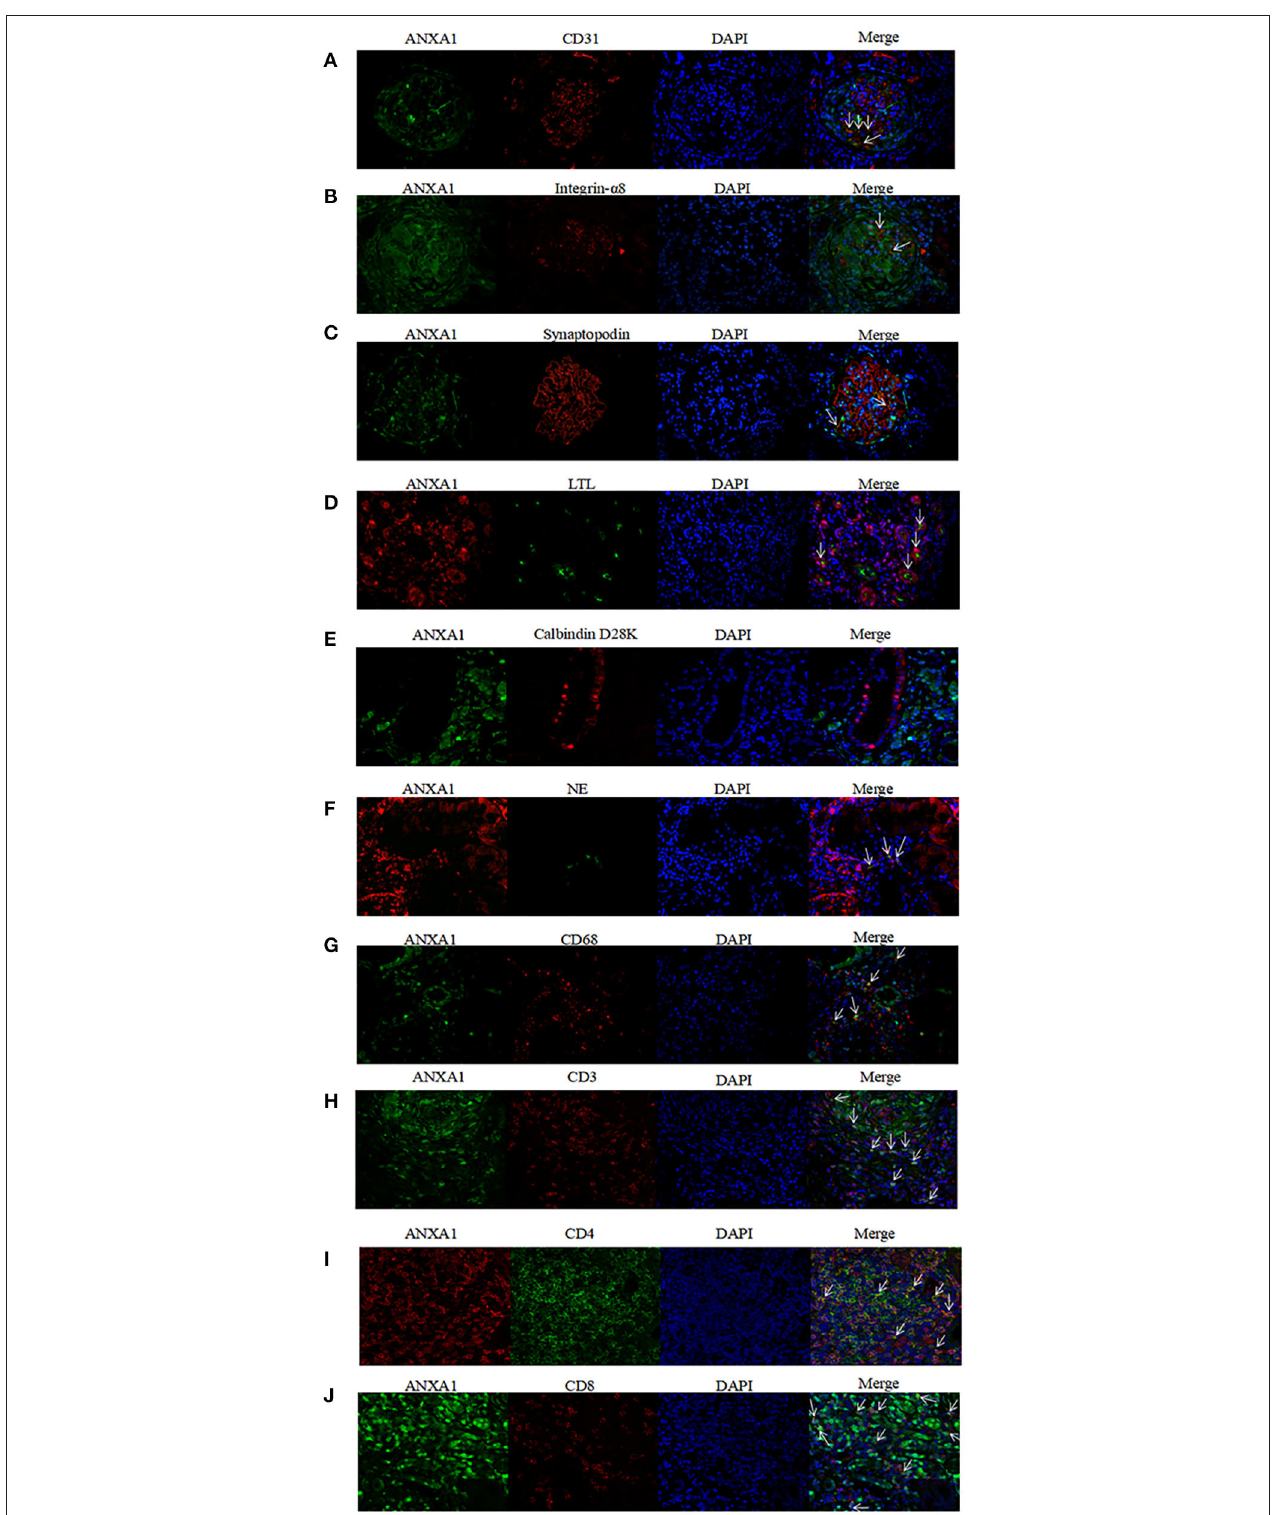
FIGURE 5 | Co-localization of ANXA1 and CD31 (A) , integrin- α 8 (B) , synaptopodin (C) , LTL (D) , Calbindin D28K (E) and NE (F) , CD68 (G) , CD3 (H) , CD4 (I) and CD8 (J) in renal specimens of AAV patients respectively. AAV, anti-neutrophil cytoplasmic antibody (ANCA)-associated vasculitis; ANXA1, annexin A1; CD3, cluster of differentiation 3; CD4, cluster of differentiation 4; CD8, cluster of differentiation 8; CD31, cluster of differentiation 31; CD68, cluster of differentiation 68; LTL, lotus tetragonolobus lectin; NE, neutrophil elastase.